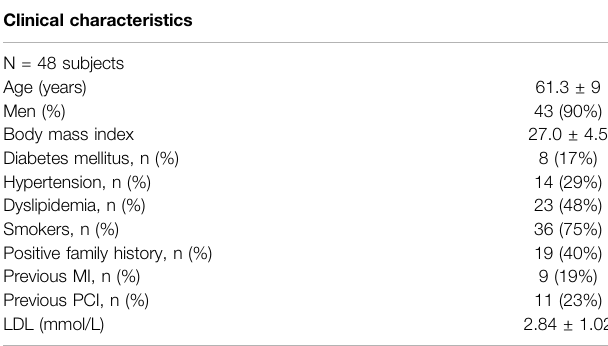
TABLE 1 | - Human dataset clinical